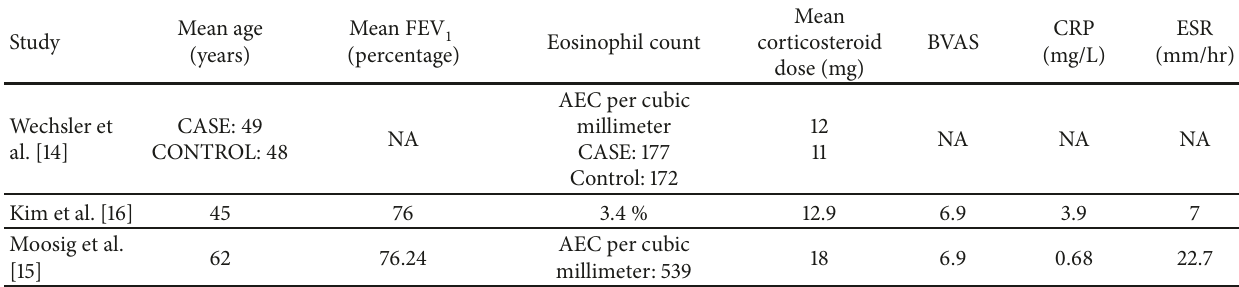
Table 2: Baseline characteristics of patients included in selected